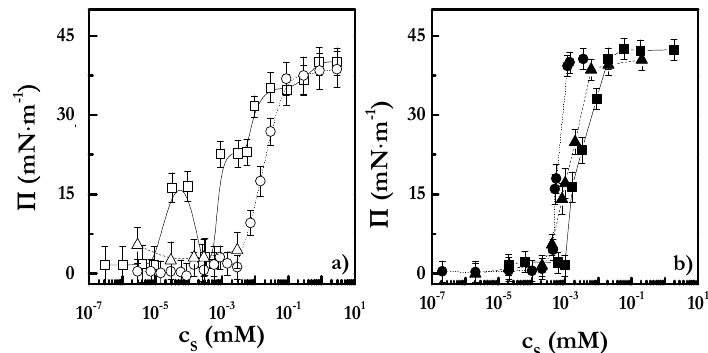
Figure 3. Surface pressure isotherms for solutions of PDADMAC with the two surfactants, obtained using different tensiometers. ( a ) Isotherms for PDADMAC-SLMT solutions. ( b ) Isotherms for PDADMAC-SLES solutions. Note: ( □ and ■ ) Surface force tensiometer with Pt Wilhelmy plate as contact probe; ( ○ and ● ) surface force tensiometer with paper Wilhelmy plate as contact probe; ( Δ and ▲ ) drop profile analysis tensiometer. The lines are guides for the eyes. The results correspond to PDADMAC-surfactant mixtures containing a fixed PDADMAC concentration of 0.5 wt.% left to age